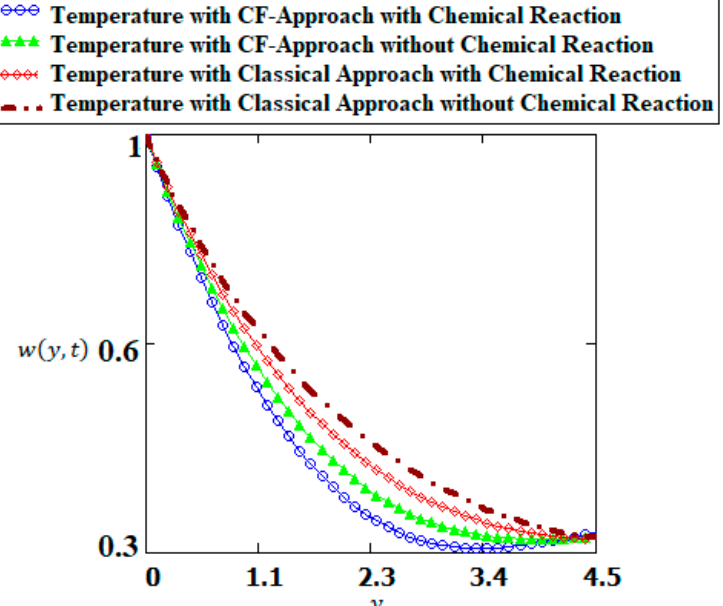
Figure 7. Comparison of velocity field depicted from Equation (19) with 𝛷 (cid:3404) 0 and 𝛿 (cid:3405) 1 , Equa ‐ tion (19) for 𝛷 (cid:3405) 0 and 𝛿 (cid:3405) 1 , Equation (19) for 𝛷 (cid:3405) 0 and 𝛿 (cid:3404) 1 .